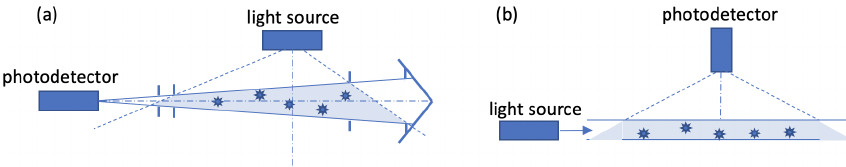
Figure 3. Diagrams of the (a) cell-direct nephelometer and (b) cell-reciprocal